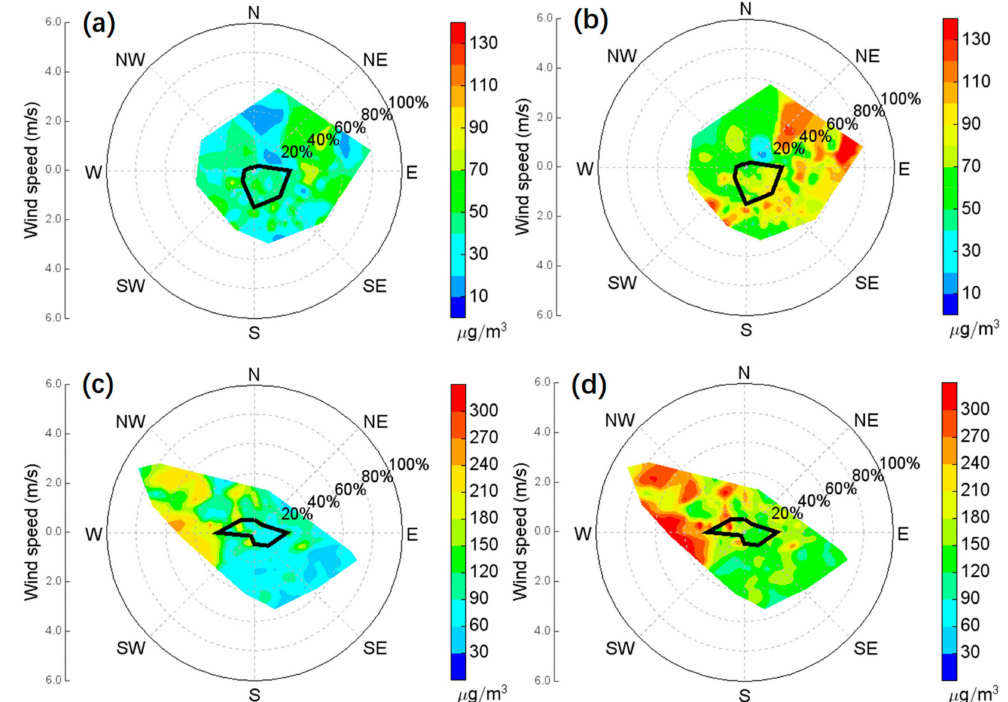
Figure 4. Concentration contours of PM 2.5 / 10 (in µ g m − 3 ) overlaid on wind roses for PM 2.5 during summer ( a ) and winter ( c ) episodes, and similarly for PM 10 during summer ( b ) and winter ( d ) episodes. PM 2.5 / 10 concentrations (in µ g m − 3 ) are color-coded following the color scale to the right of each wind rose. The overlying thick black lines indicate wind direction frequency (%). The wind speed (in ms − 1 ) scale is provided to the left of each